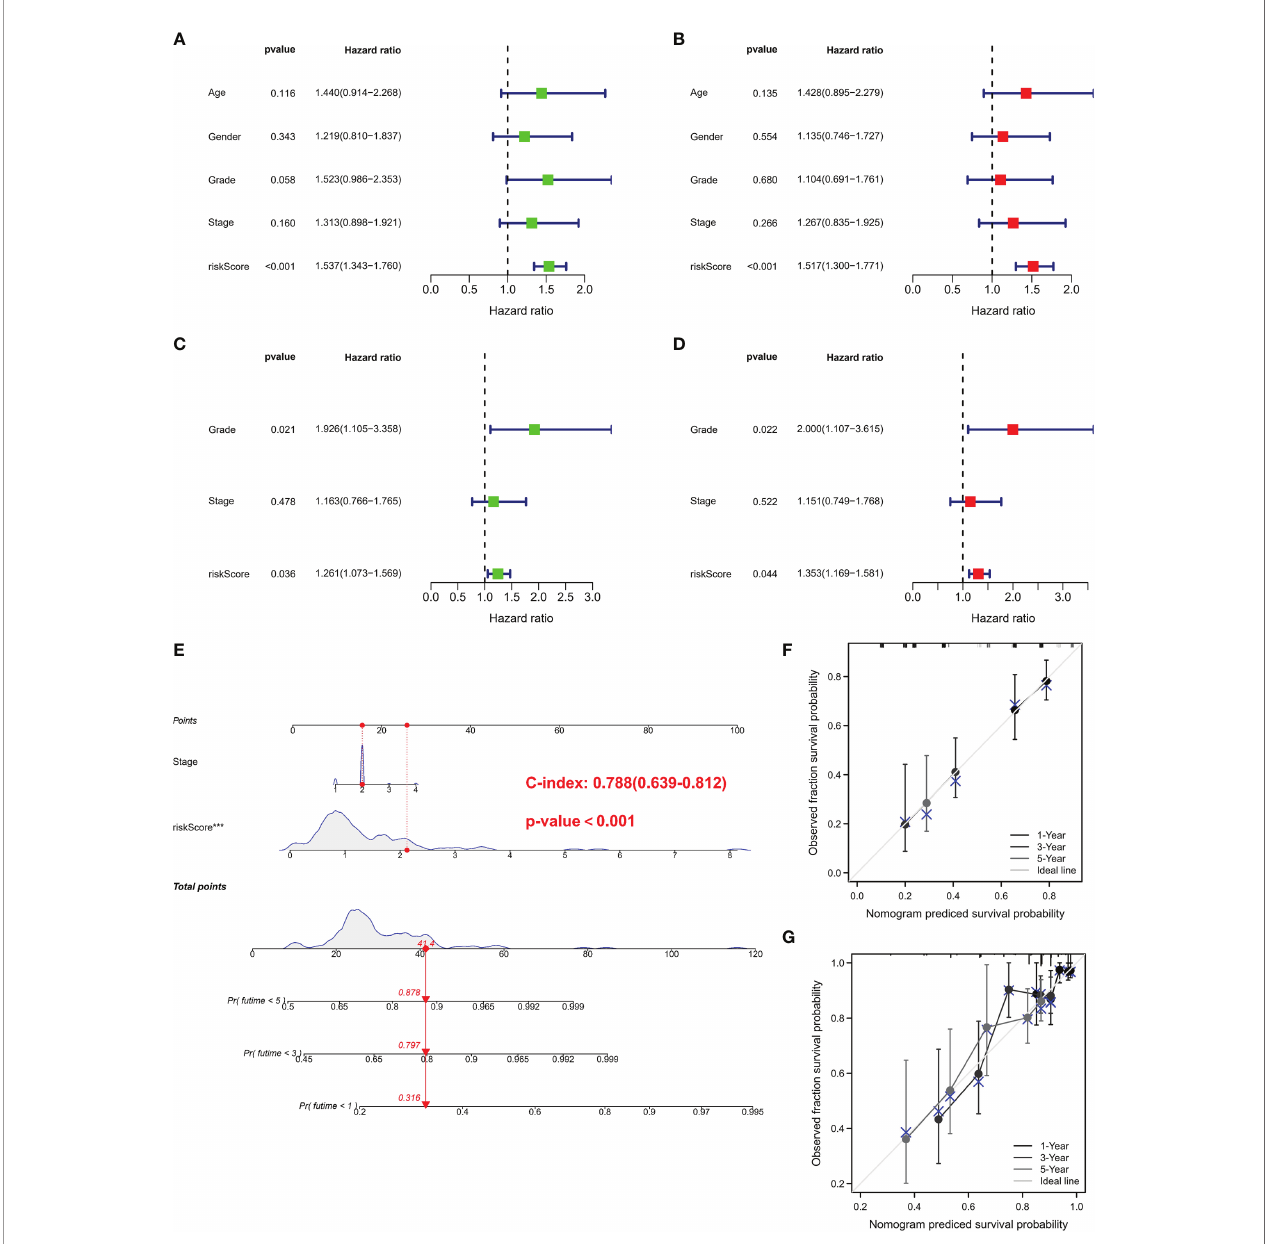
FIGURE 4 | Independent prognostic validation and construction of nomogram. (A) Univariate assessment for TCGA cohort (grade: degree of tumor differentiation, G1 to G3; stage: the size of the primary tumor and the degree to which the cancer has spread in the patient ’ s body, I to IV). (B) Multivariate analysis for TCGA cohort. (C) Univariate analysis for the GEO cohort. (D) Multivariate analysis for the GEO cohort. (C, F) Heatmap (green: low expression; red: high expression) for the connections between clinicopathologic features and risk groups. (E) Nomogram. (F, G) Nomogram to predict 1-, 3-, and 5-year overall survival rates of PC patients. Calibration curve for the overall survival nomogram model in the discovery group. A dashed diagonal line represents the ideal nomogram. PRG, pyroptosis-related gene; PC, pancreatic